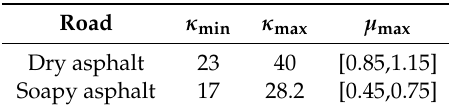
Table 2. Slip slope κ and µ max ranges obtained in [7].